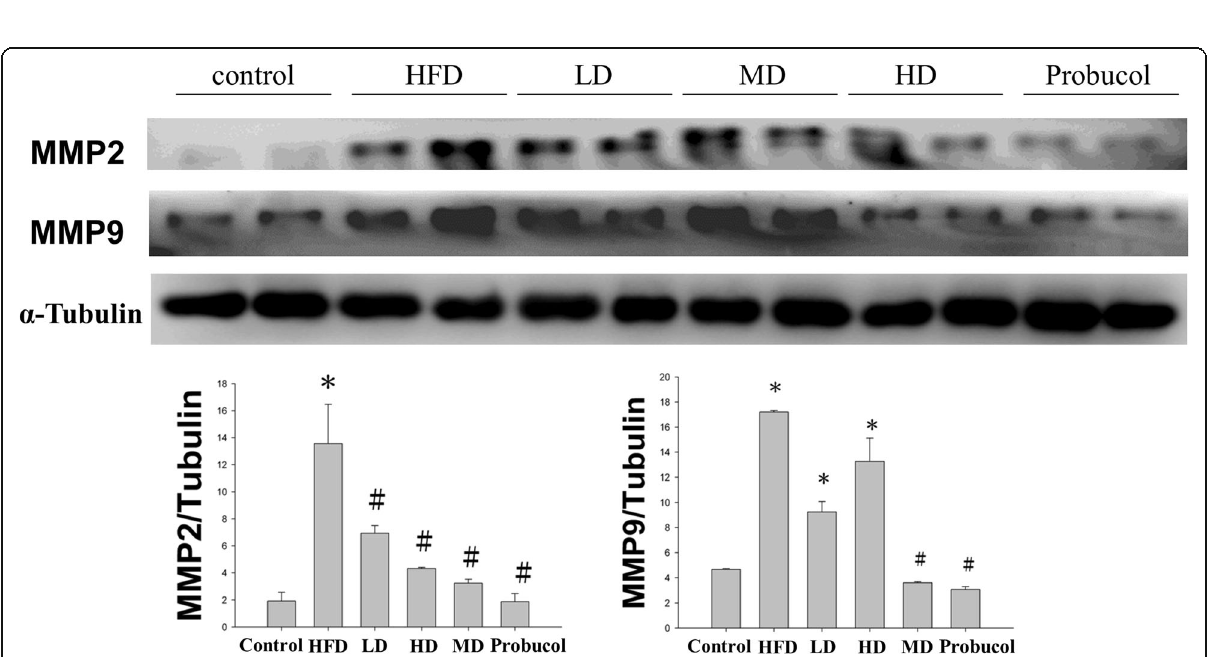
Fig. 3 Apoptosis and survival Protein expression analysis by western blotting. Levels of apoptosis and survival related proteins in the liver sections of Control, HFD fed hamsters (HFD), HFD fed hamsters treated with low dose of APPH (L-APPH), HFD fed hamsters treated with moderate dose of APPH (M-APPH), HFD fed hamsters treated with high dose of APPH (H-APPH) and HFD fed hamsters treated with probucol. n = 5, * p < 0.05 when compared with the Control group; # p < 0.05 when compared with HFD group